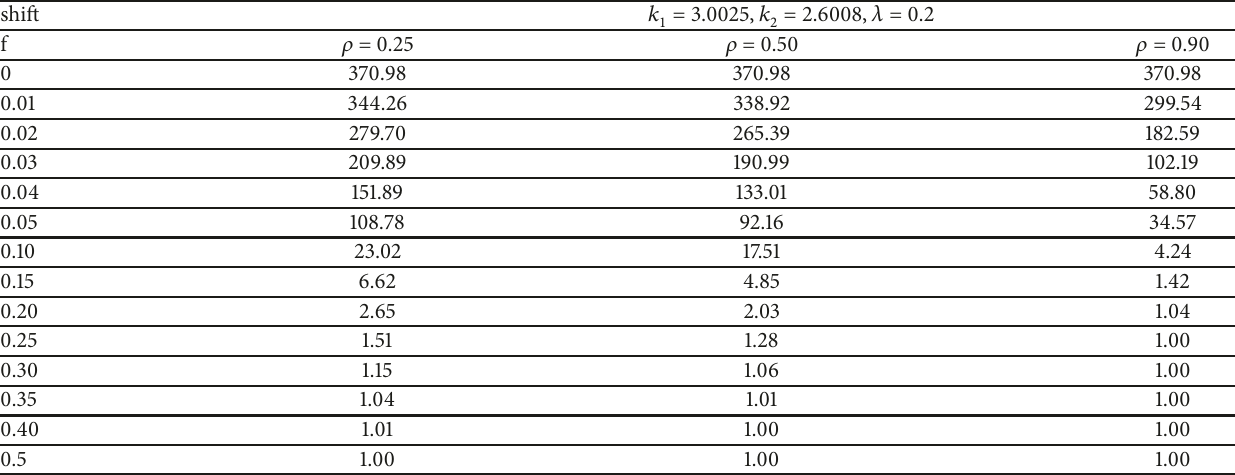
Table 5: ARLs for proposed repetitive EWMA-RSS control chart using Bahl and Tuteja (1991) exponential ratio-type estimator, when 𝑟 𝑜 is